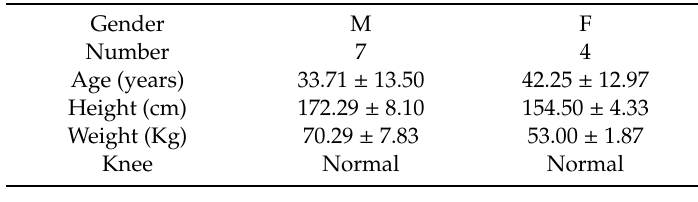
Table 2. Eleven subjects’ characteristics.